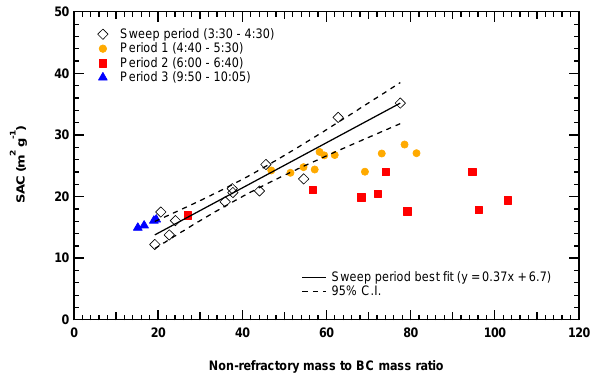
Figure 5: Relationship between SAC and the non-refractory mass to BC mass ratio for four different periods observed on June 21, 2007, during the BAQS-Met field study. The open black diamonds represent the sweep period when the BC particles were mainly in an internally mixed condition. Some of these open diamond points are directly from the steel mill, while others (at higher SAC) are associated with more-aged internally mixed particles brought to the surface due to break up of the nocturnal boundary layer. Period 1 (orange circles), 2 (red squares), and 3 (blue triangles) represent different periods when other local airmasses were impacting the site. The straight line represents a linear regression fit for the black open diamonds while the dashed lines represent the 95% confident intervals.